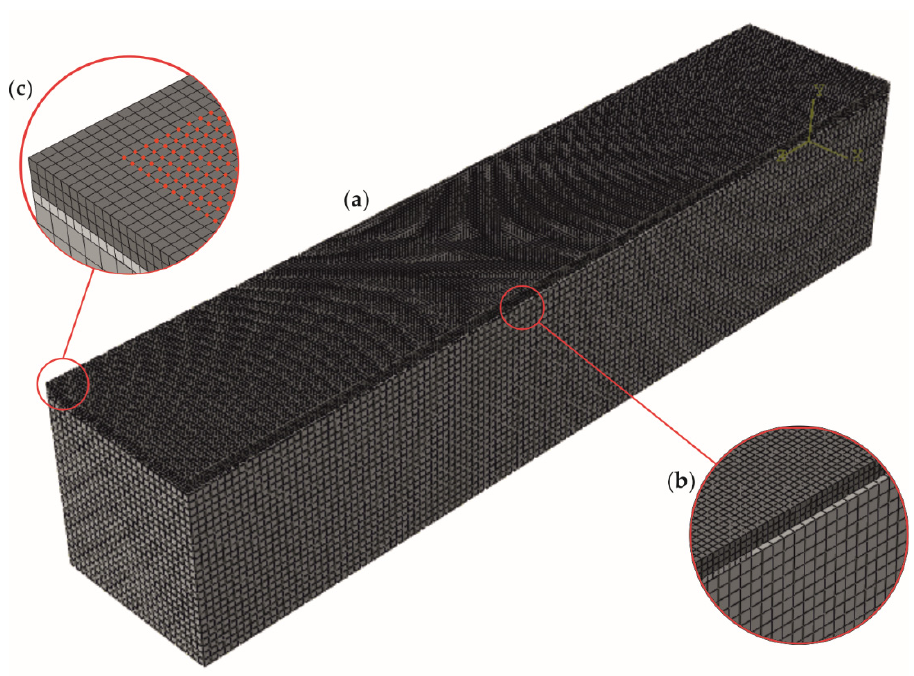
Figure 3. Numerical model ( a ) with a close-up of damage ( b ) and measurement grid ( c ) based on the #3 model.